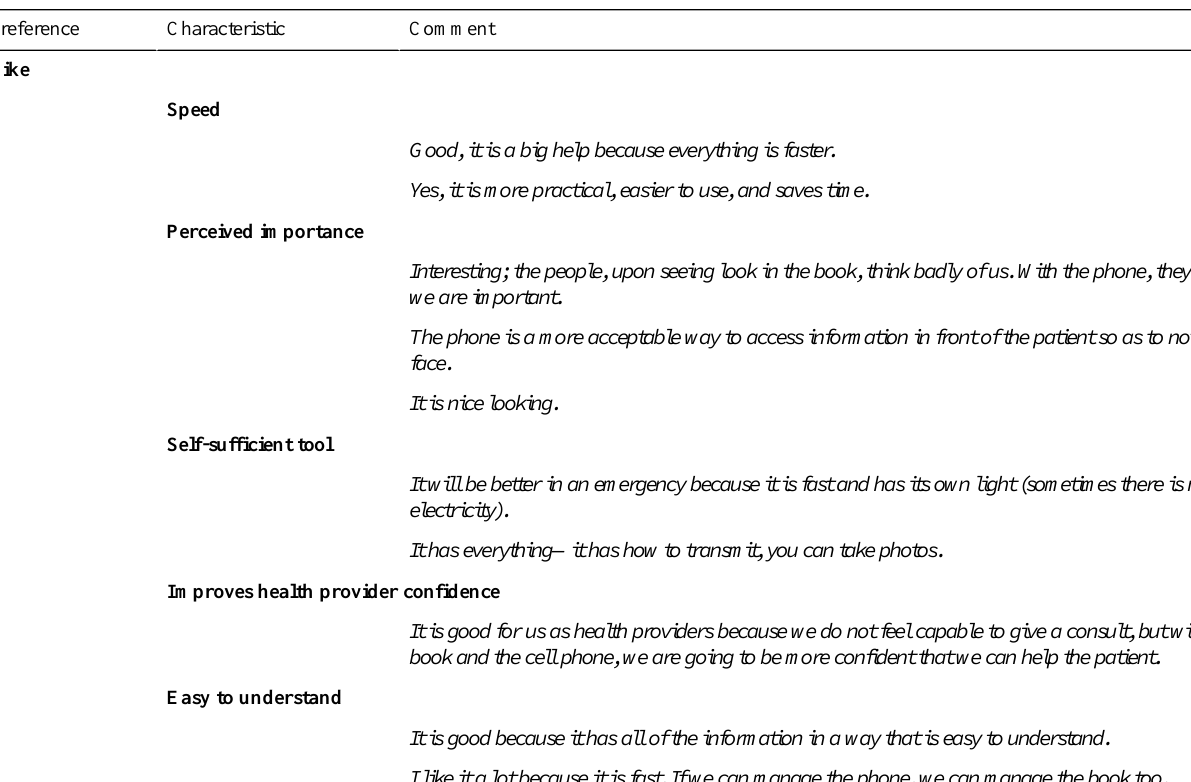
Table 3. Narrative responses about acceptability of the mHealth tool.